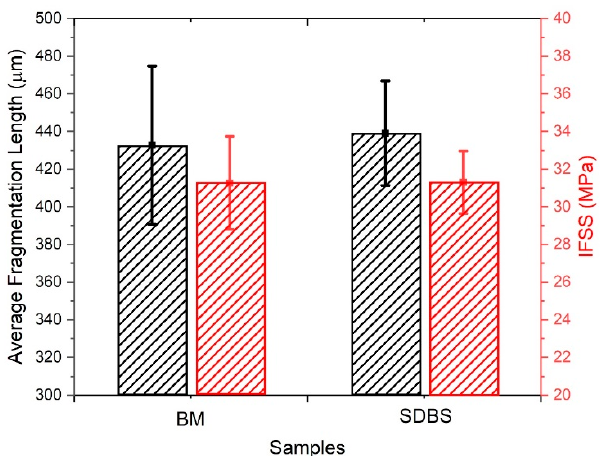
Figure 6. Average fragment length and the interfacial shear strength (IFSS) for benchmark samples (BM) and the SDBS modified samples. (For interpretation of the references to colour in this figure, the reader is referred to the web version of this article).